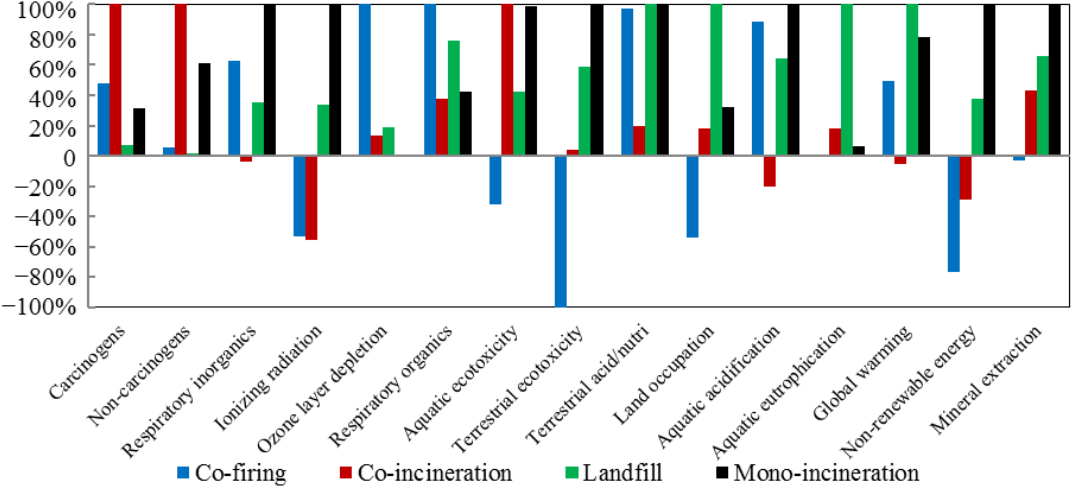
Figure 3. Characterization of the mid-point environmental effects of four sludge-handling